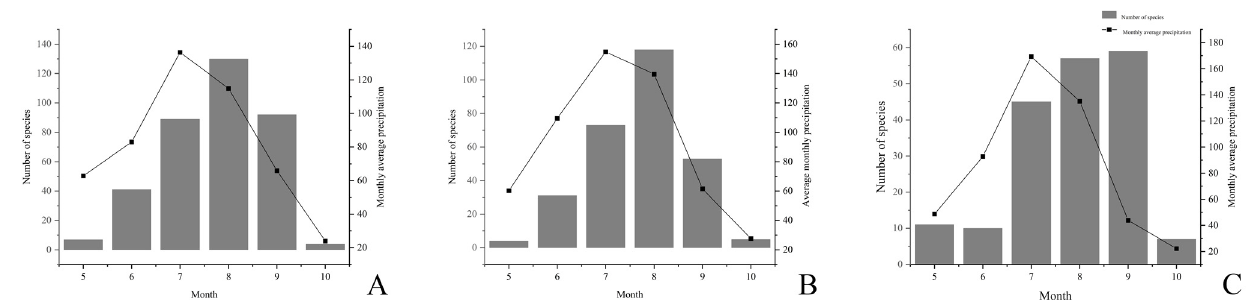
Figure 11. Effect of precipitation on the occurrence of macrofungi in three different investigation sites from Jilin Province. ( A ) Quanshuidong Forest Farm; ( B ) Shengli River Forest Farm; ( C ) Jingyuetan National Forest Park.